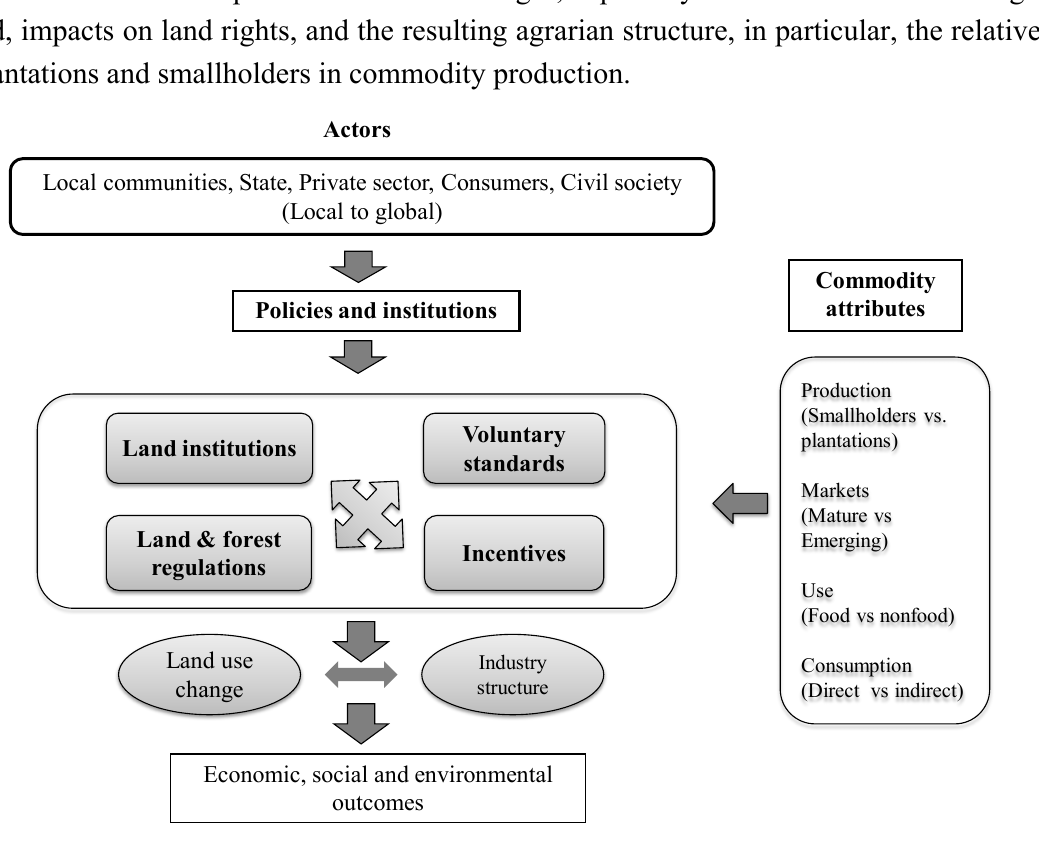
Figure 1. Simplified framework for analyzing outcomes for land use and land